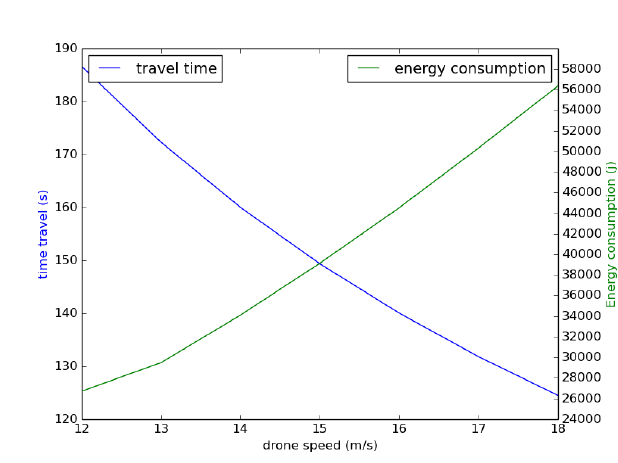
optimal solution but a number of other near optimal paths with a trade-o ff betw een length distance and probability of localiza tion determined by the drone fligh